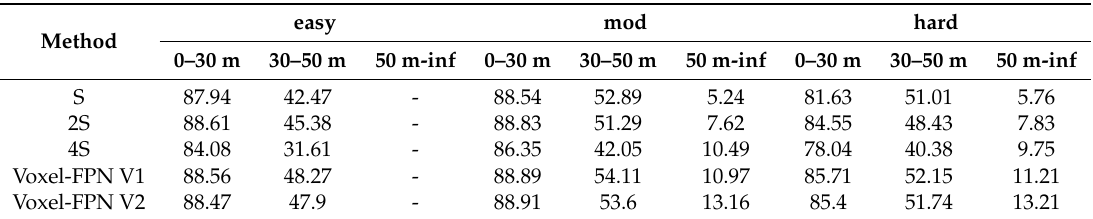
Table 4. Detection performances of partition methods with different voxel sizes in different ranges (S = 0.16